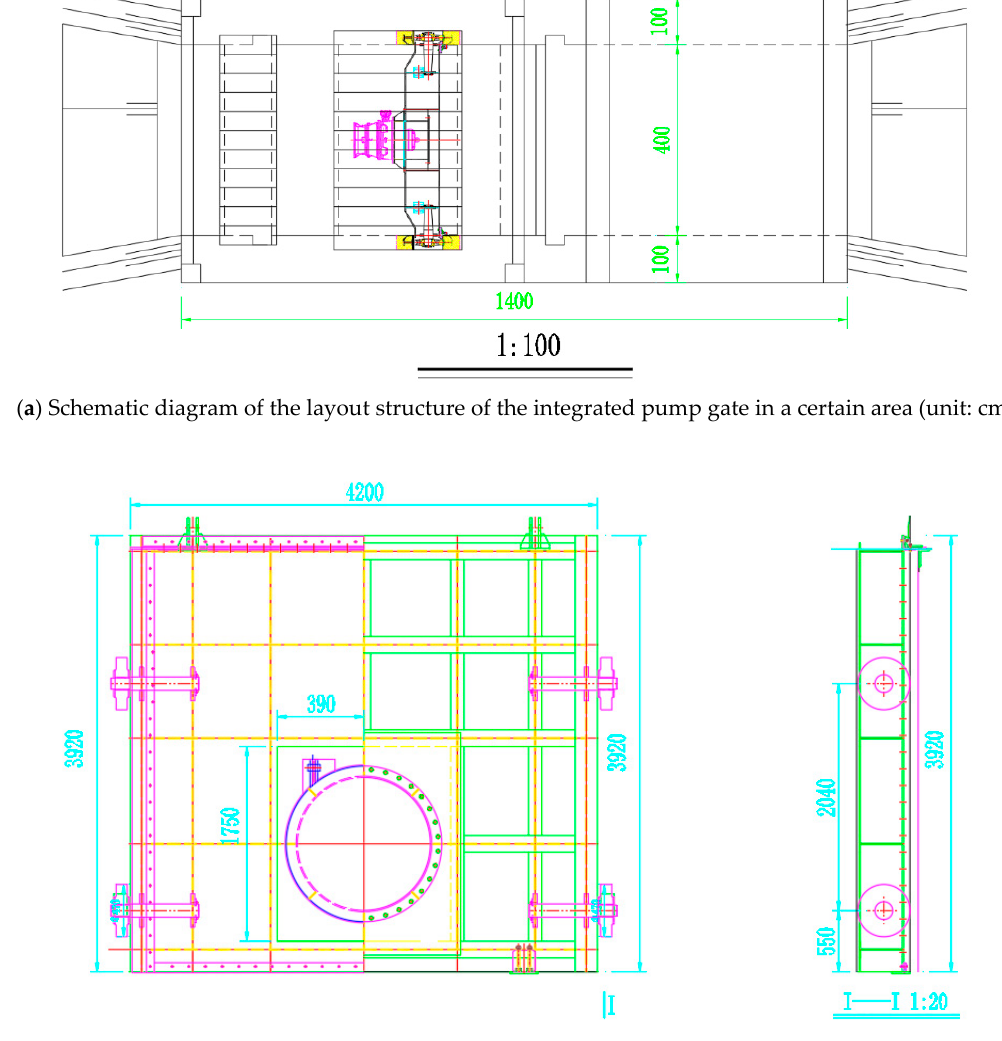
Figure 2. Schematic diagram of the plane layout of the integrated pump gate and the size and structure of the gate.